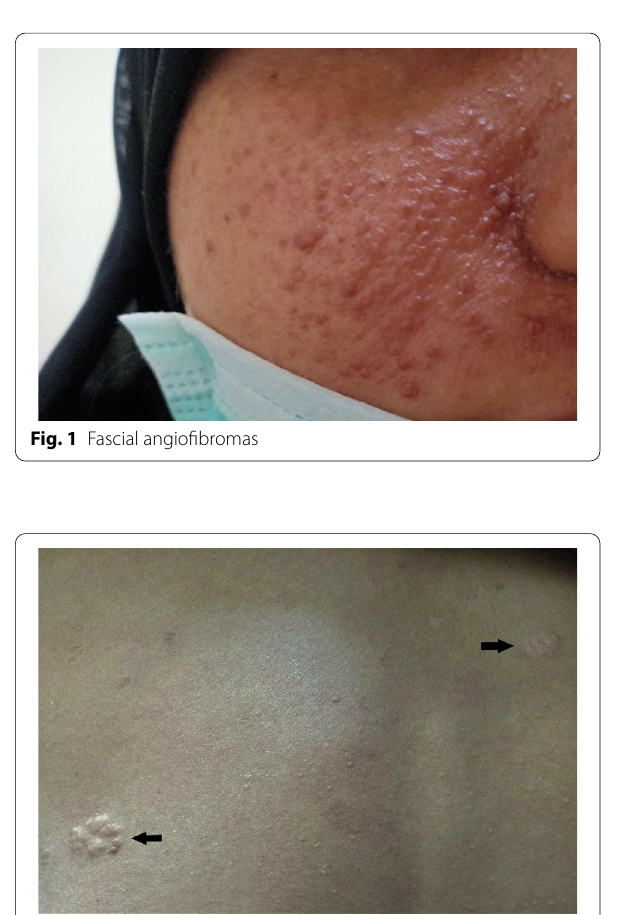
Fig. 2 ‘Orange peel’ appearance of a shagreen patch